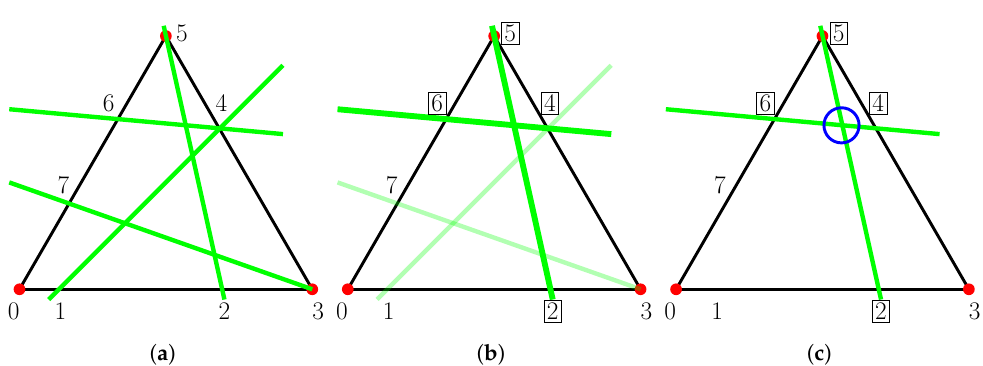
Figure 8. Intersections inside triangles (vertices and intersections on boundary indexed in order).